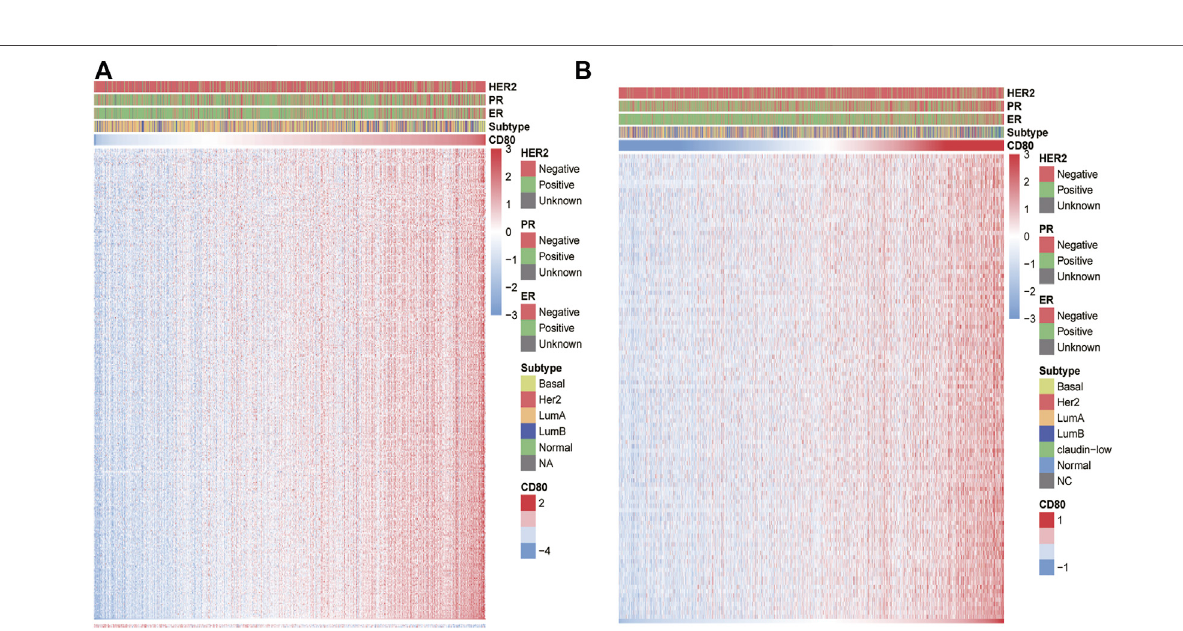
Frontiers in Pharmacology |